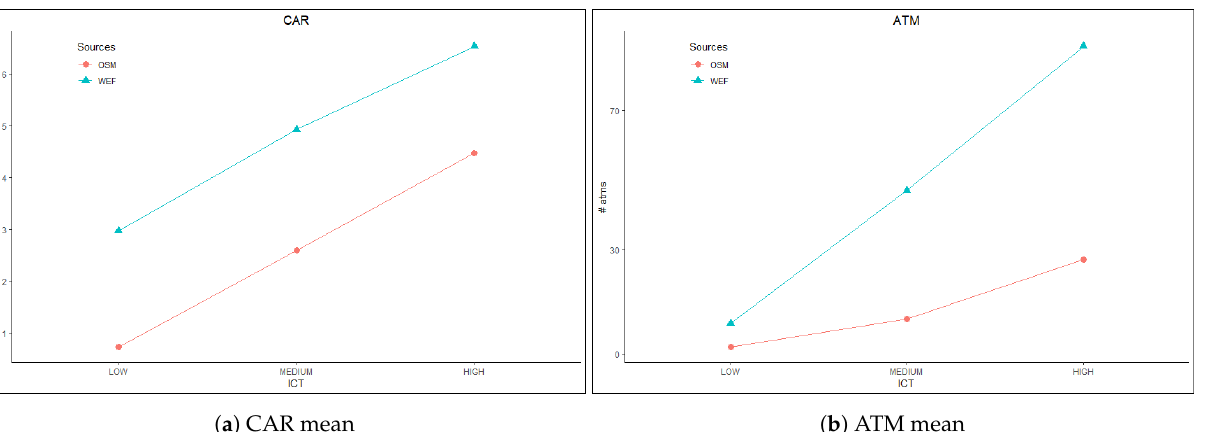
Figure 3. CAR and ATM variables mean for different ICT